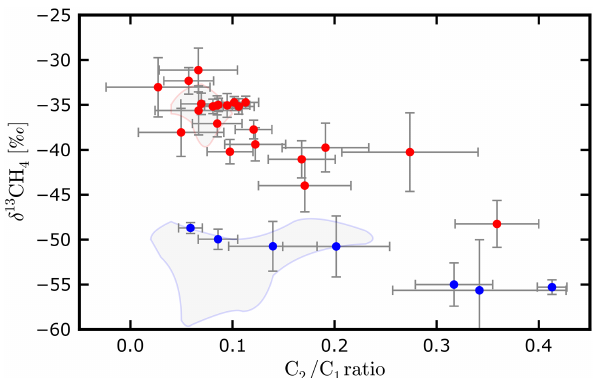
Figure 12. δ 13 CH 4 and ethane-to-methane ratios for plumes from 21 natural gas wells (red) and seven oil wells (blue) in the Uin- tah Basin. All of the natural gas measurements were of plumes in the Natural Buttes field in the basin; the oil well measurements were mostly in the Monument Butte field. The natural gas signa- tures are consistent with previous observations of production gases in the Uintah Basin (Rice et al., 1992), and follow trends observed in other formations for gas associated with oil production and non- associated thermogenic natural gas of various levels of maturation. The red- and blue-outlined gray areas represent distinct popula- tions of wells in the Uintah as described in Rice et al. (1992), for which it has been assumed (for simplicity) that the contribution of propane and heavier alkanes is zero. The centroids of the distribu- tion of gas well signatures are − 37 . 18 ± 3 . 9‰ and 0 . 118 ± 0 . 075 for δ 13 CH 4 and ethane-to-methane ratios, respectively, and for oil, − 52 . 31 ± 2 . 7‰ and 0 . 223 ± 0 .